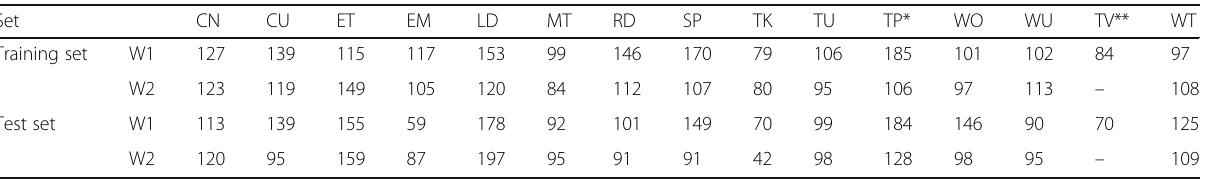
Table 7 Numbers of key frames in the image subset